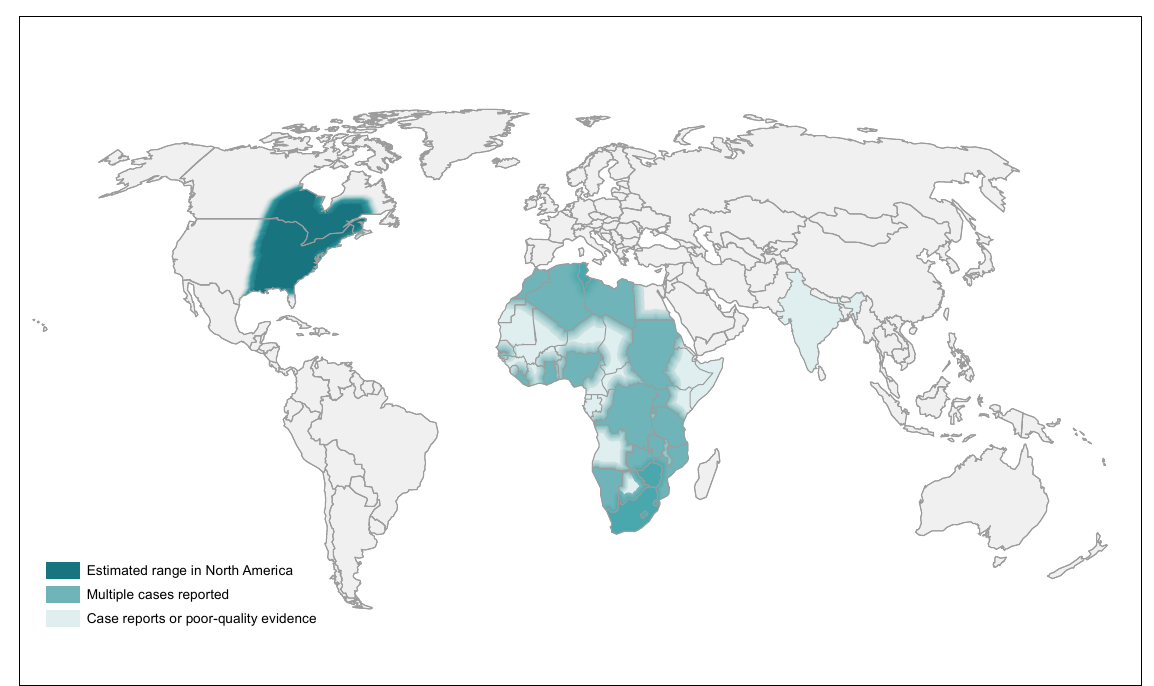
Figure 1. Map of the estimated distribution of Blastomyces . Figure used with permission from Ashraf et al. [5].